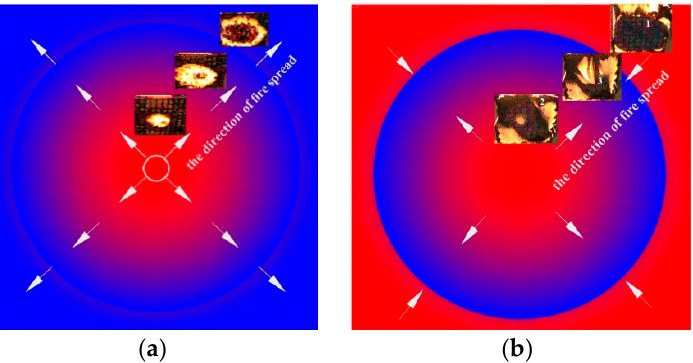
Figure 5. The flame spread law at the bottom of the sample with different thickness: ( a ) 1 cm and 2 cm; ( b ) 5 cm.